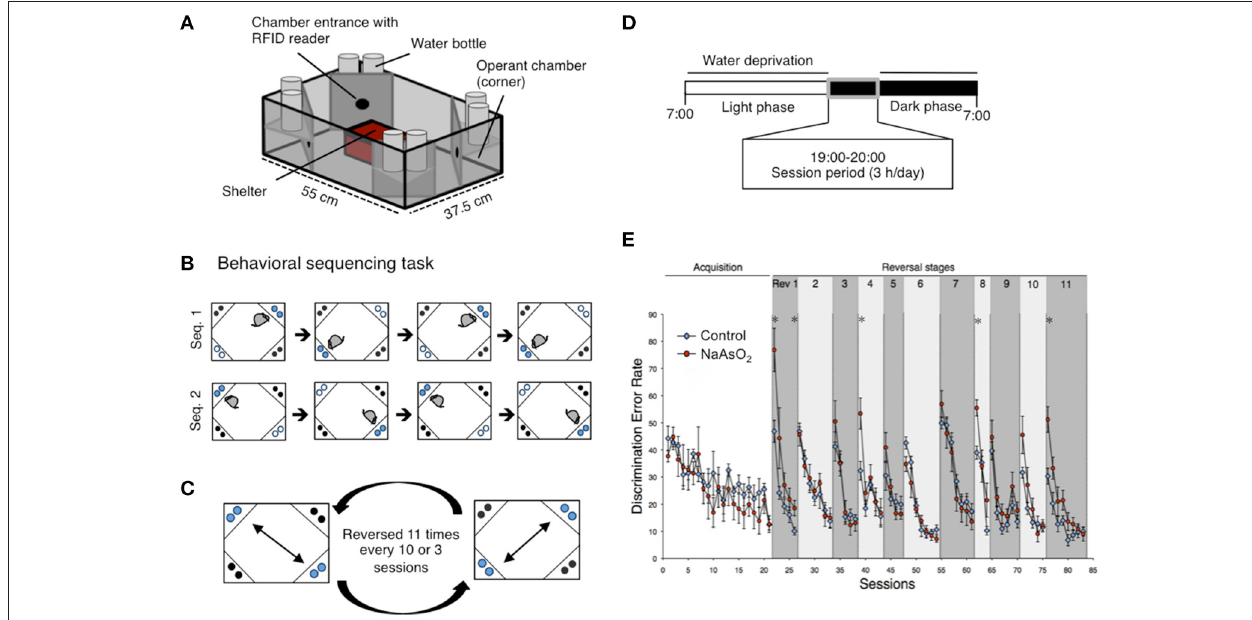
FIGURE 1 | Impaired behavioral flexibility in adult mice born to dams that were administered NaAsO 2 during gestation. (A) Overview of an IntelliCage apparatus. (B) Behavioral sequencing task. Mice were allowed to make an access to water as a reward for 4s during their visits at an active reward corner (blue circle). The location of the active reward corner was automatically alternated to a diagonally opposed corner each time the mouse received a reward. Therefore, mice obtained rewards continuously by acquiring a behavioral sequence (alternating between the two reward corners). A visit to a never-rewarded corner (black circle) was counted as a discrimination error. (C) Serial reversal task. For each mouse, the assigned spatial patterns of the rewarded corners (sequence 1 or sequence 2) were reversed 11 times every 3 or 8 sessions. (D) Timeline of the experiment for each day. (E) Learning performance of control or NaAsO 2 -exposed female mice in the behavioral flexibility test. Discrimination error rates (the number of discrimination errors in the first 100 corner visits of a session) are expressed as mean ± SEM (control group n = 8, NaAsO 2 -exposed group n = 6). An asterisk indicates a statistical difference ( p < 0.05) from the control